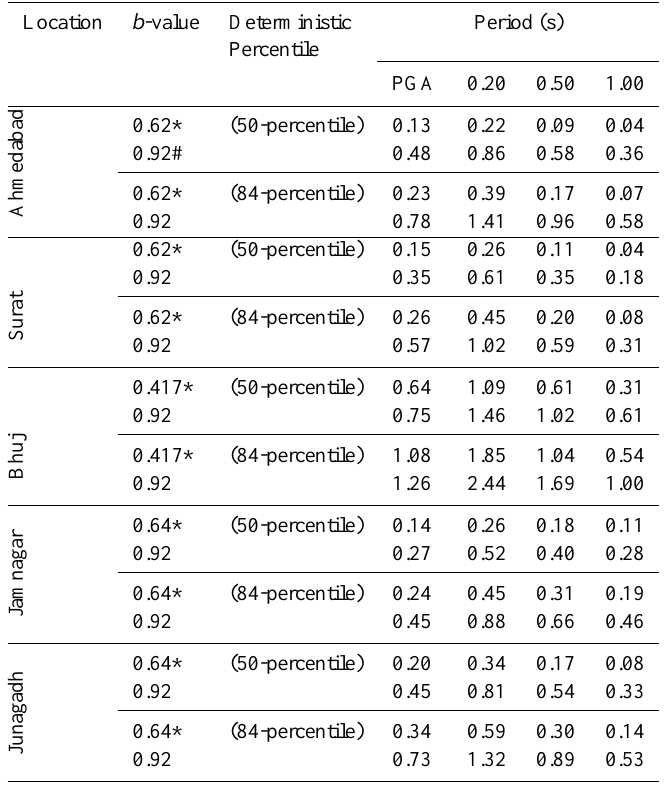
Table 6. Deterministic seismic 1 spectral ordinates for few reference